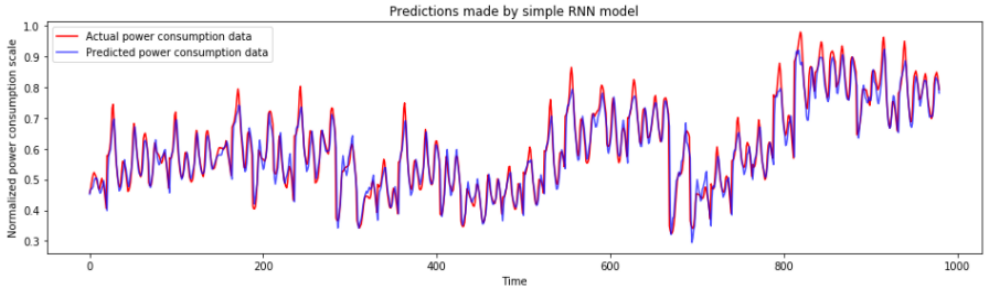
Figure 10. Forecast result of simple-RNN with respect to test dataset over time (day).